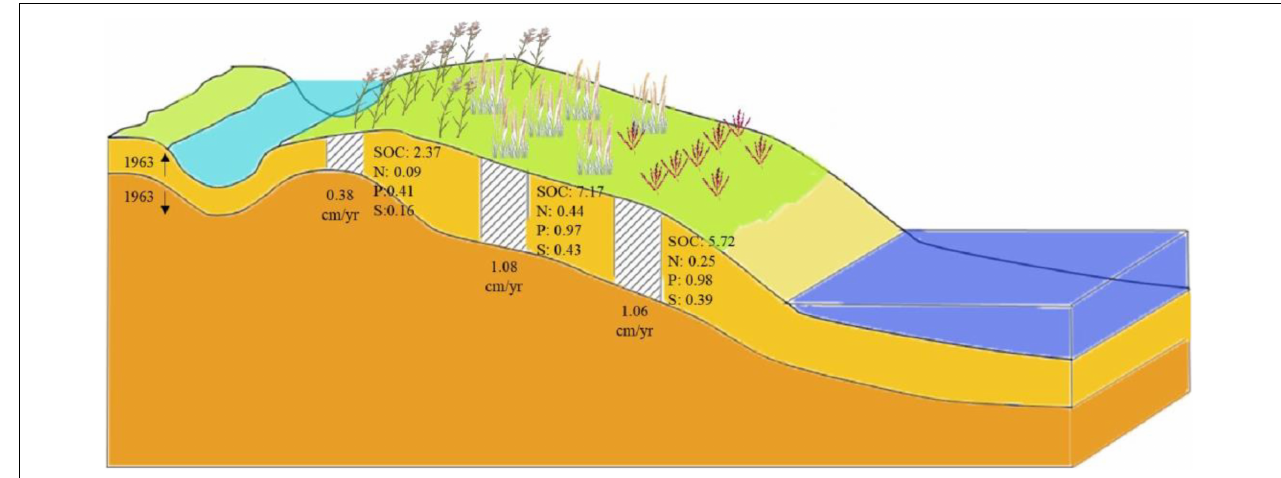
FIGURE 4 | Soil sedimentation rate and sedimentation flux of C, N, P, and S in the YRD.